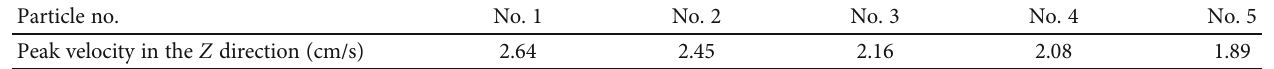
Table 12: Peak values of the vibration velocity in the Z direction without a free surface. Particle